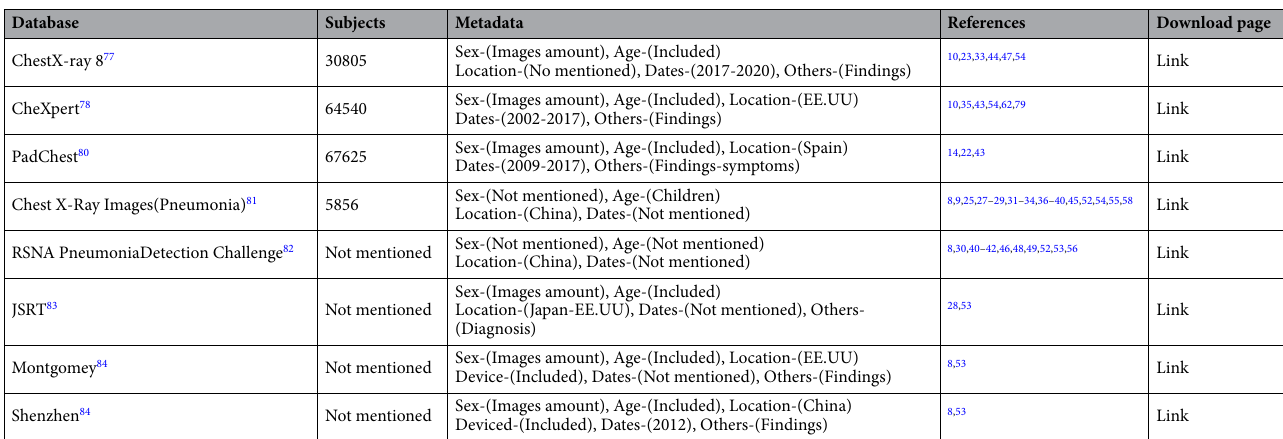
Table 2. Control databases found with the number of papers that use it, references, and where to find the